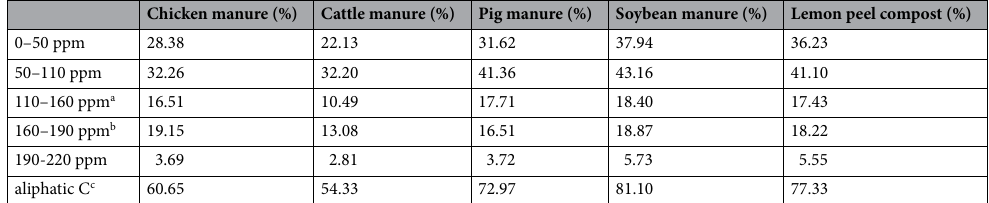
Table 8. The 13 C NMR spectroscopy of five different composts. a Characteristic carbons in the range of chemical shift are assigned as aromatic C. b Characteristic carbons in the range of chemical shift are assigned as carboxylic C. c Expressed by the sum of the percentages of the characteristic carbons in the range of chemical shifts of 0–50, 50–110